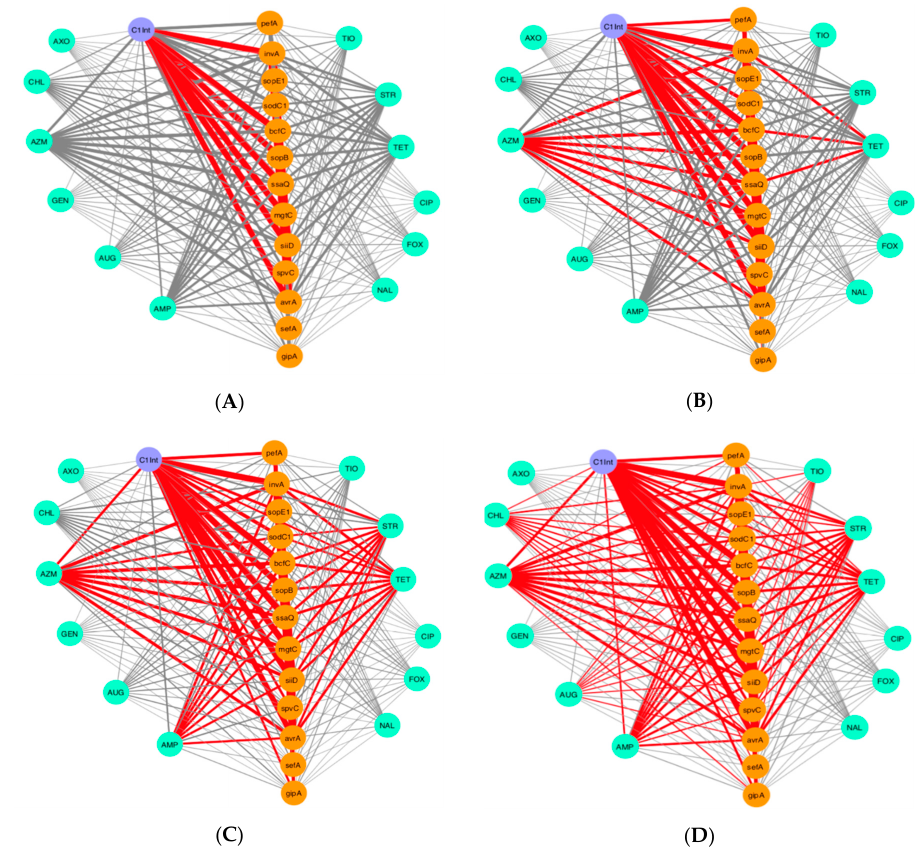
Figure 2. Visualization of co-occurrence pattern of phenotypical drug resistance and prevalence of virulence genes across Salmonella isolates ( n = 211). No connections are shown between drug (i.e., antibiotic) resistance genes to better emphasize connections between drug resistance and virulence. The red lines (e.g., edge) indicate a high incidence of connections that occur together between drug resistance and virulence among the isolates. The thickness of the line between nodes denotes the frequency of isolates that share the same coinciding connections. Nodes in cyan, orange, and purple are antibiotic resistance, virulence genes, and the integron-associated integrase gene, respectively. ( A ) Observed connections between drug resistance and virulence genes across 100 out of 211 isolates. ( B ) Observed connections between drug resistance and virulence genes across 70 isolates out of 211 isolates. ( C ) Observed connections between drug resistance and virulence genes across 50 isolates out of 211 isolates. ( D ) Observed connections between drug resistance and virulence genes across 25 isolates out of 211 isolates. Key: amoxicillin/clavulanic acid (AUG), ampicillin (AMP), azithromycin (AZM), cefoxitin (FOX), ceftiofur (TIO), ceftriaxone (AXO), chloramphenicol (CHL), ciprofloxacin (CIP), gentamicin (GEN), nalidixic acid (NAL), streptomycin (STR), tetracycline (TET). 3.4. Predictive Analysis of Drug Resistance as Indicated by Virulence Genes by Random Forest We explored further this relationship by utilizing a machine learning approach, using the Random Forest algorithm, to predict which virulence genes could better indicate (i.e., used as a proxy) for the potential presence of certain types of drug resistance. The Random Forest analysis shows the top three virulence genes that are associated with antibiotic resistance include gipA , pefA , and spvC (Figure 3A). Among these genes, gipA , a bacteriophage-associated virulence gene, has the